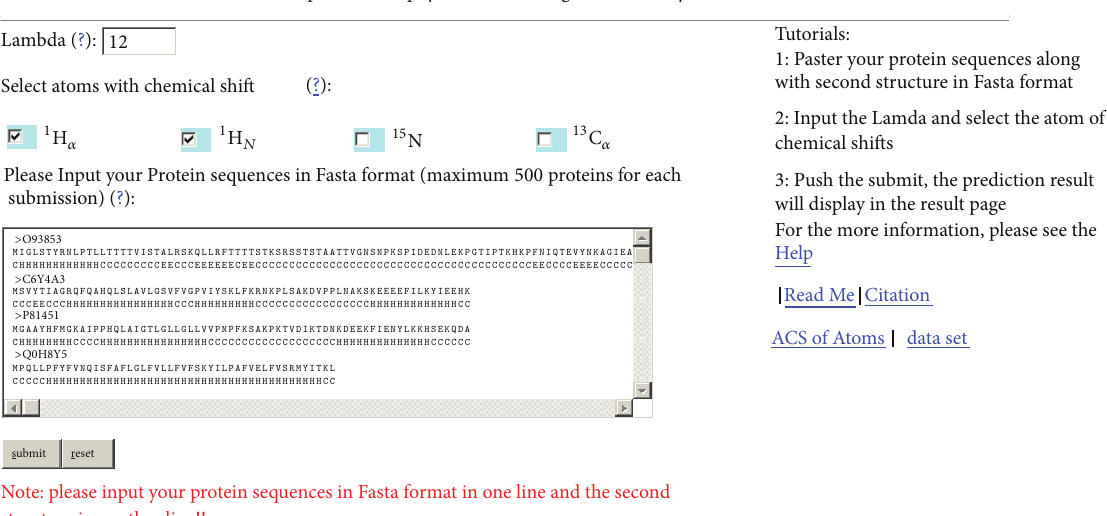
Figure 4: A screenshot for the top page of the web server acACS at http://wlxy.imu.edu.cn/college/biostation/fuwu/acACS/index.asp. The protein functions, including its subcellular locations, are largely determined by its structure. Developing a novel method for improving the performance of predicting protein subcellular locations is urgent. However, the feature vectors in the methods were almost sequence-based in the past. There- fore, almost state-of-the-art methods tried to incorporate some other sequence-based information as its